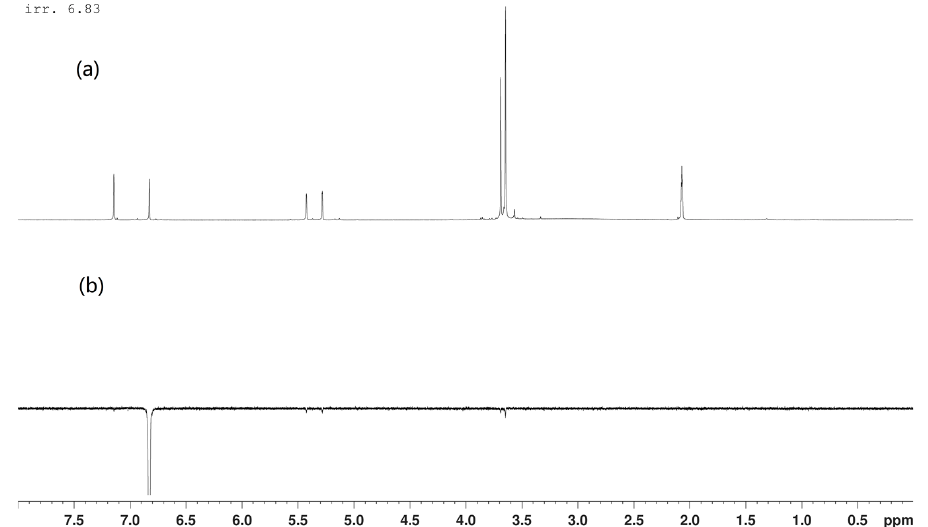
Figure 3. ( a ) 1 H-NMR spectrum of 2 measured in acetone- d 6 and ( b ) selective 1D NOESY spectrum of 2 : selective irradiation of H-5 ( δ H = 6.83 ppm) using selnogp.3 Bruker program (parameter set: ns 128, p12 = 80 ms, and d8 = 400 ms).